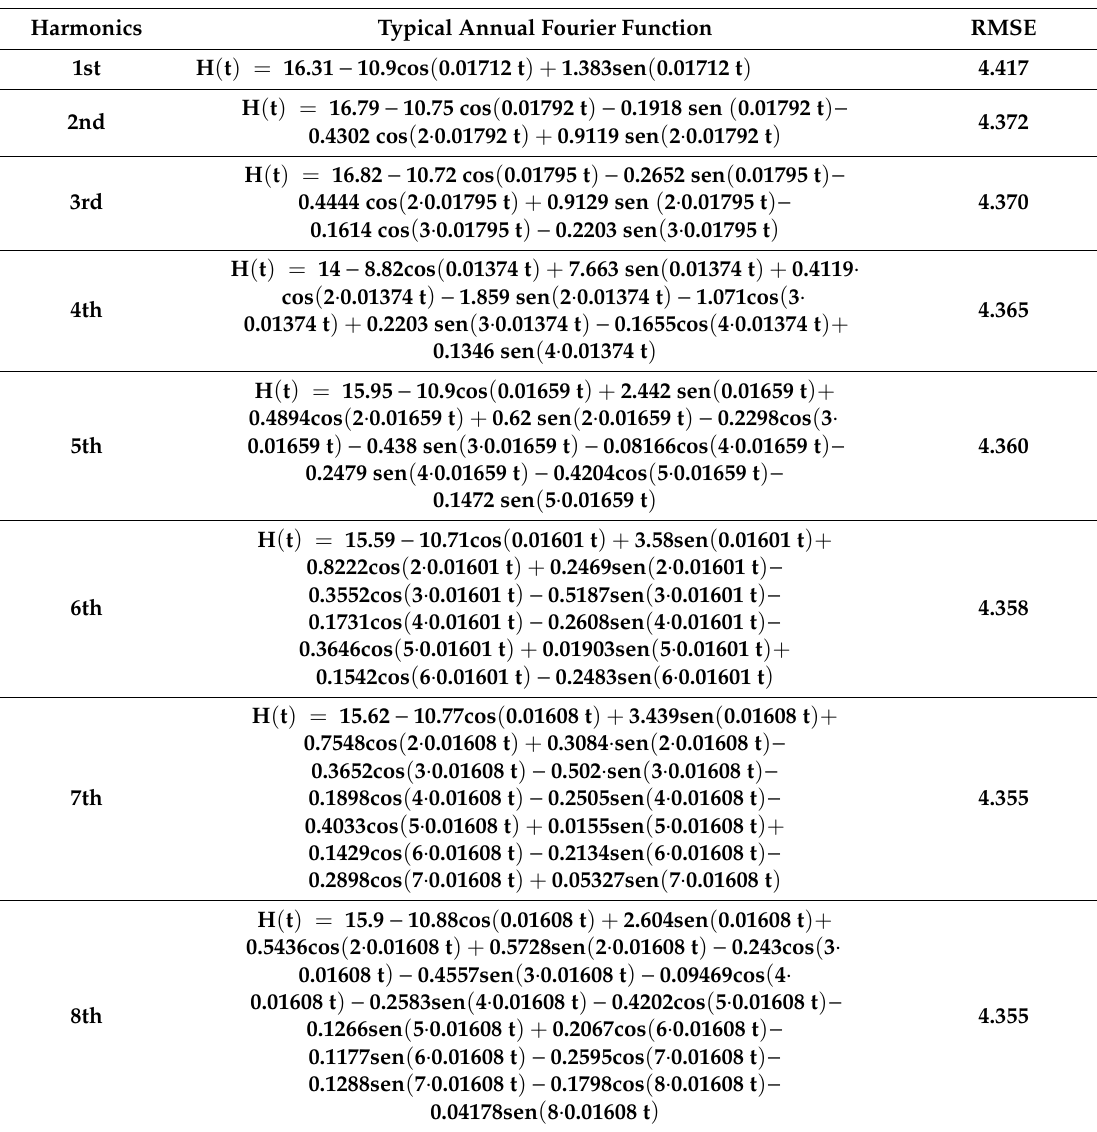
Table 3. Typical annual Fourier models for the horizontal daily global solar irradiation [H(t), MJ / (m2 · d)], from the first to the eighth harmonic. Data from the SIAR agrometeorological station at Mansilla Mayor, Le ó n, Spain, for the period between 2004 and